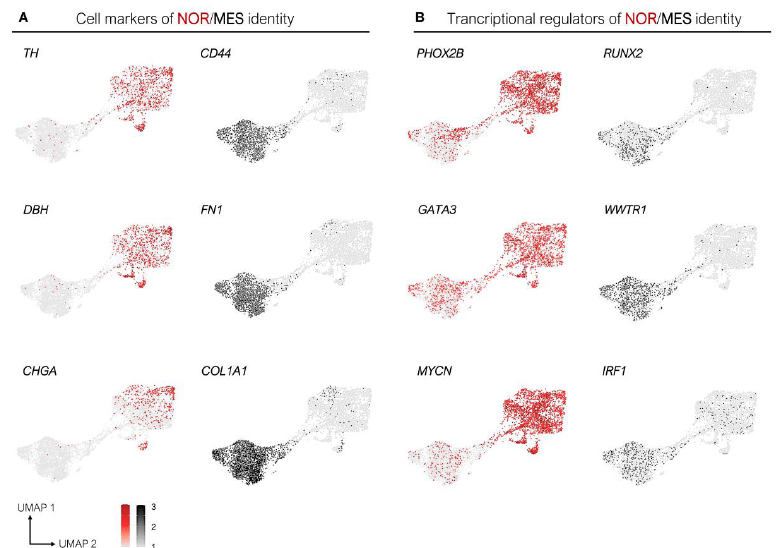
Figure 3. The IC-pPDXC-63 cell line is biphenotypic in vitro and resumes expression of known specific 1 cellular markers and transcription regulators of the NOR and MES identities. UMAP representation of the single-cell RNA-sequencing of the IC-pPDXC-63 model, with each dot corresponding to a cell [29]. ( A ) The TH and DBH enzymes as well as the neuroendocrine secretory protein CHGA are expressed in noradrenergic cells, while CD44, COL1A1 , and FN1 are specifically expressed in cells of mesenchymal identity. ( B ) The transcriptional regulators PHOX2B , GATA3 , and MYCN are specifically expressed in noradrenergic cells, while RUNX2 , WWTR1 , and IRF1 exhibit the opposite expression